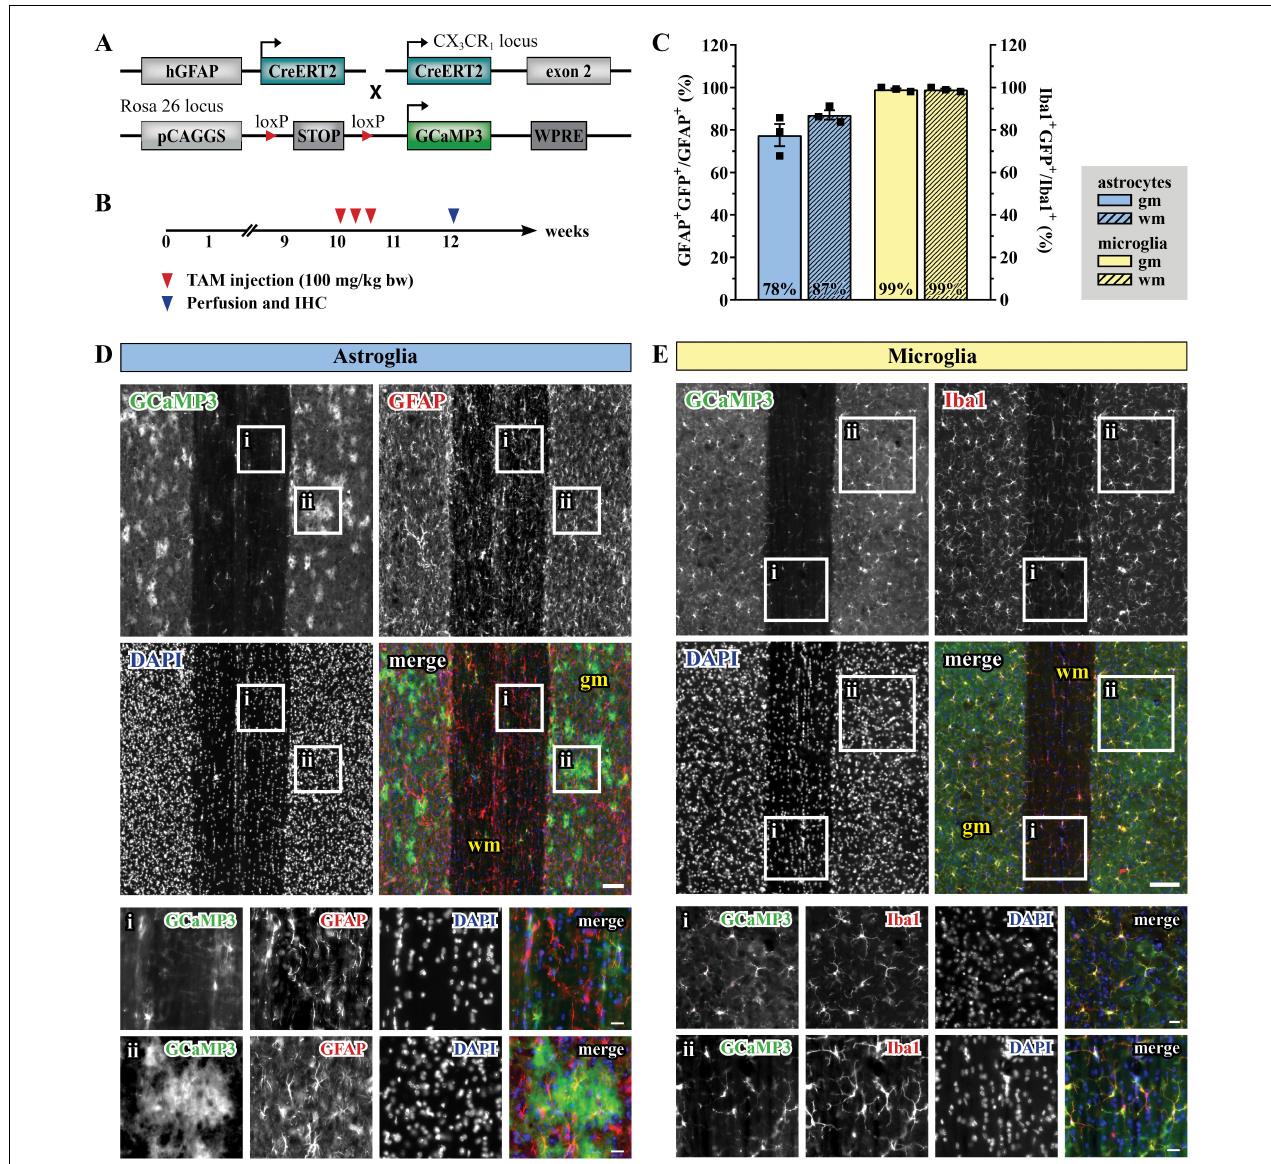
FIGURE 1 | Tamoxifen- induced GCaMP3 expression in astrocytes and microglia. (A) Scheme of transgenic constructs carrying CreERT2 and GCaMP3. (B) Experimental design for the GCaMP3 induction in 10-weeks old mice injected with TAM (tamoxifen). (C) Recombination efficiency for hGFAP GCaMP3 (blue, left Y-axis) and CX 3 CR 1GCaMP3 animals (yellow, right Y-axis) in gray ( gm ; solid) and white matter ( wm , dashed), respectively. (D) Evaluation of longitudinal spinal cord slices for cell-specific GCaMP3 (green) expression in astroglia (GFAP, red) and (E) microglia (Iba1, red) with nucleic staining (DAPI, blue). Neither Iba1 + GCaMP3 + nor GFAP + GCaMP3 + cells were detected in the hGFAPCre ERT2 or CX 3 CR 1 -Cre ERT2 animals, respectively. (Di,Ei) wm , magnified view; (Dii,Eii) gm , magnified view. Scale bar, 100 µ m (overviews) and 20 µ m (magnified